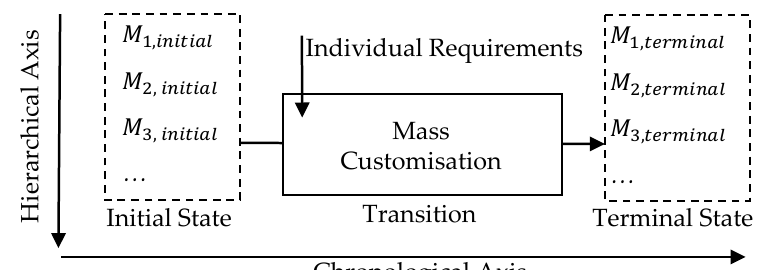
Figure 2. Illustration of the MC Design Process model’s top level, including a hierarchical and a chronological axis to guide the process from an undesired initial State to a desired terminal State by at least one Transition.